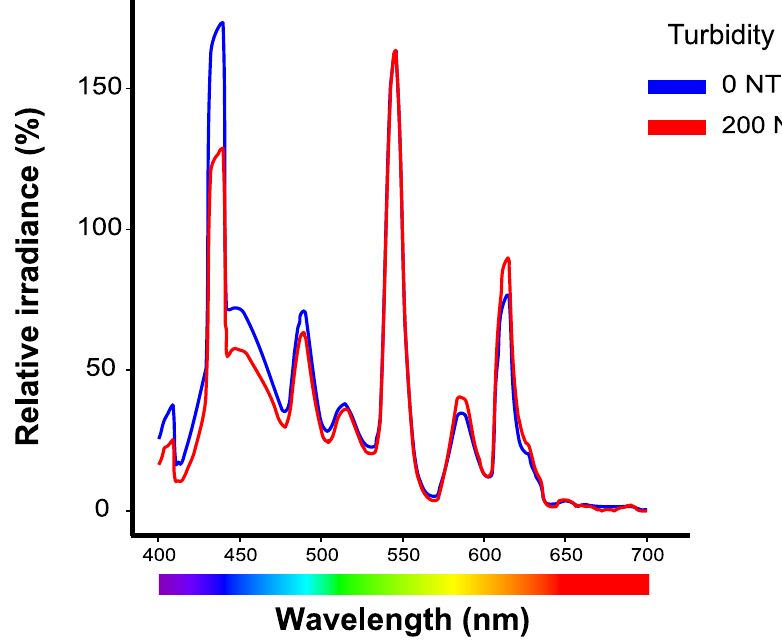
Fig 3. Upward light spectra of the 0 NTU and 200 NTU measured inside experimental aquaria. The relative spectral irradiance normalized by using the intensity at the mid wavelength from 400 nm to 700 nm, 550 nm, is 100%.